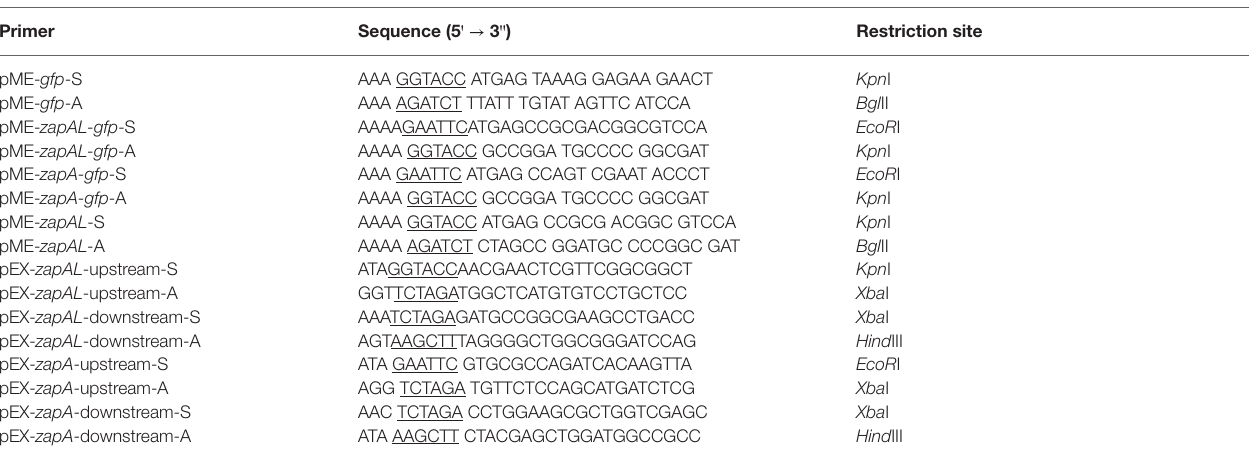
TABLE 2 | Primers used in this